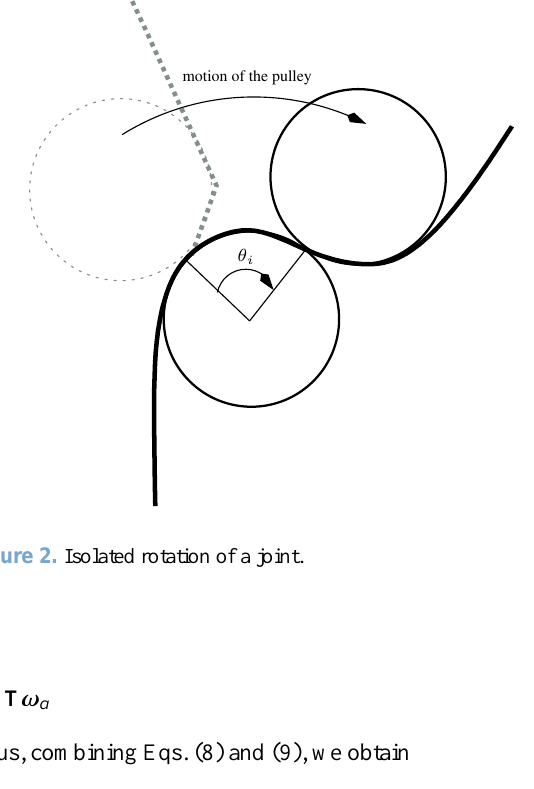
Fig. 2. ISOLATED ROTATION OF A JOINT. Figure 2. Isolated rotation of a